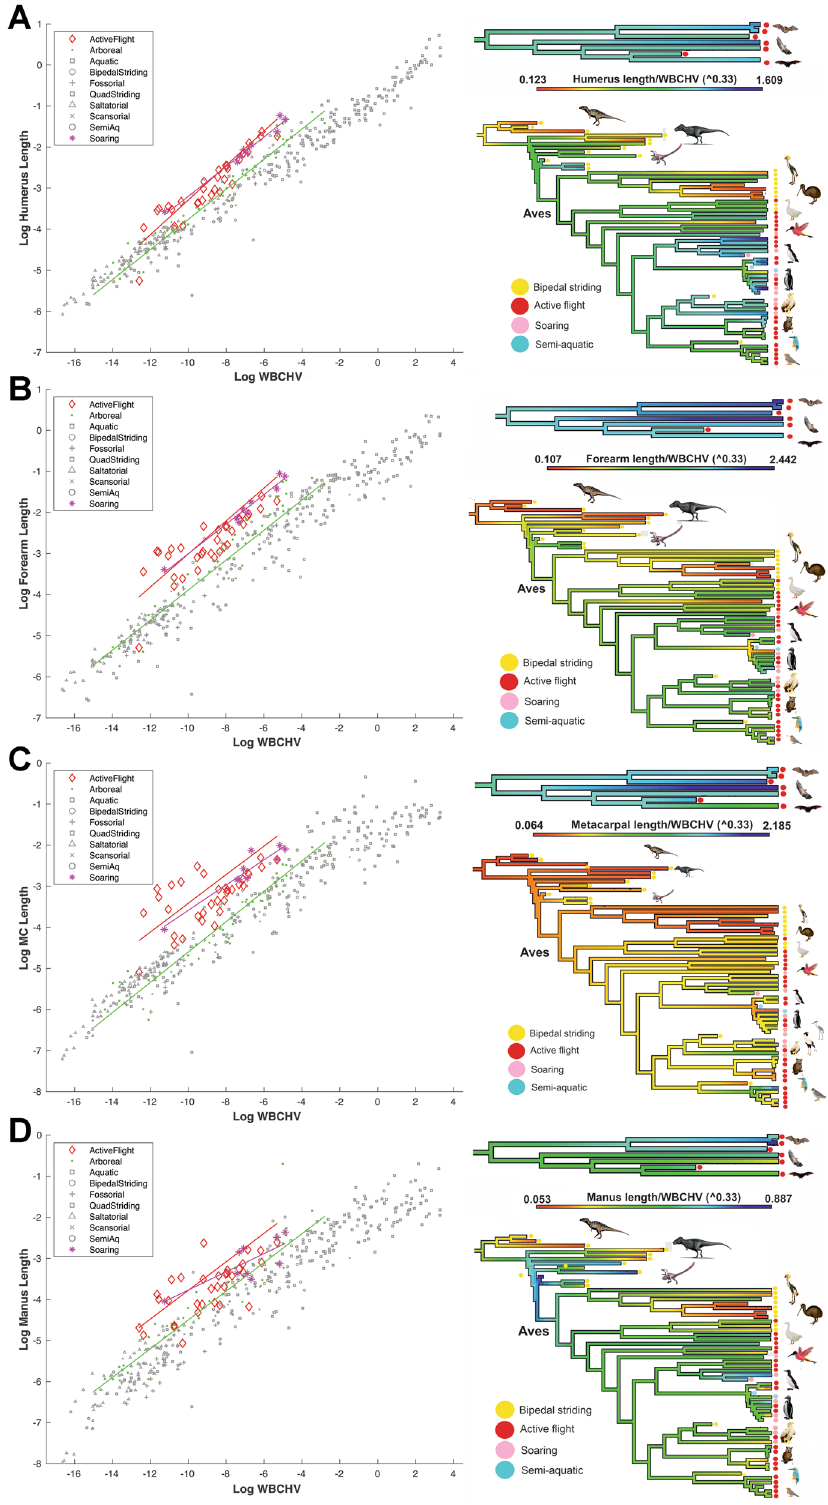
Fig. 5 | Forelimb lengths in tetrapods. Forelimb elongation in fl ying and arboreal taxa (Hypothesis 5). Arboreal taxa have relatively long forelimb seg- ments and are statistically different to several other locomotor groups. Active and soaring fl iers are statistically supported as having the longest A humeral, B forearm, C metacarpal and D manus segment lengths of all locomotor categories. Both groups also show similar positive allometry in proximal limbs segments ( A , B ) that are statistically greater than most other locomotor categories but differ from each other in the allometry of distal forelimb